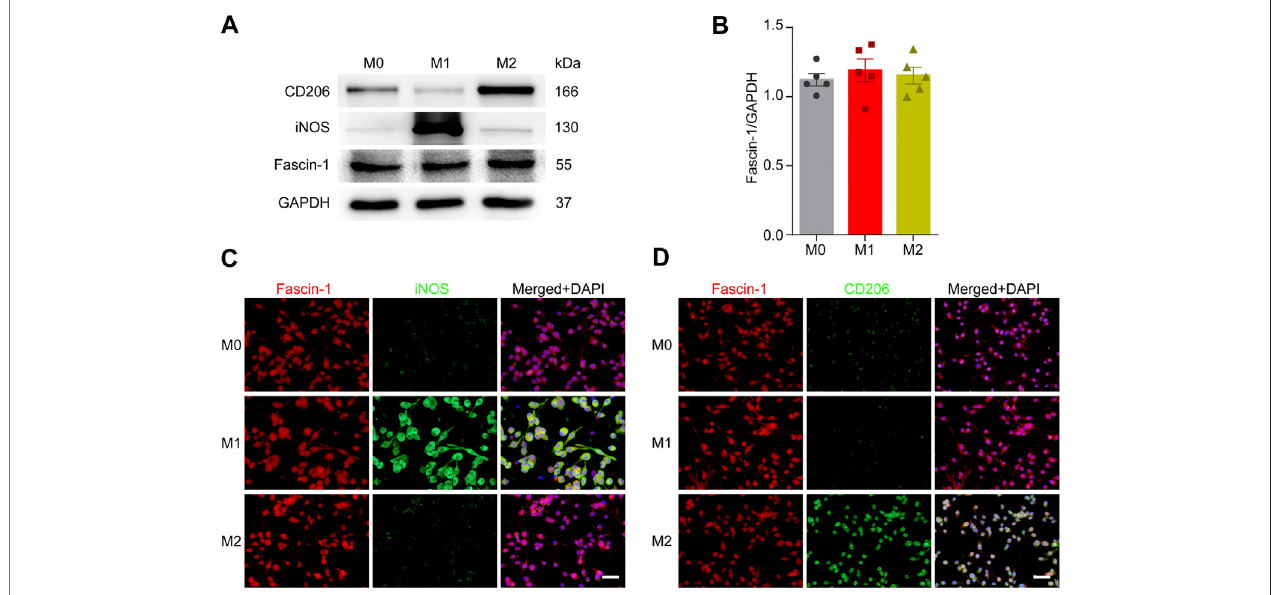
FIGURE 7 | Microglial polarization has no effect on Fascin-1 expression. (A) Western blot analysis shows the protein expression of M1-like (iNOS) or M2-like (CD206) polarization markers and Fascin-1 in BV-2 cells after polarization treatment. (B) Quantitative analysis of Fascin-1 expression in (A) . GAPDH was used as the loading control. The blots ( n (cid:2) 5 per group) were quanti fi ed, as previously described, and no signi fi cant difference was observed. (C,D) Representative immuno fl uorescence imagesof M1-like (iNOS, Green) or M2-like (CD206, Green) markers and Fascin-1(Red) in BV-2 cells after polarization treatment. The results also indicated no obvious differential expression of Fascin-1. DAPI (Blue) was used to stain the nuclei. Scale bar: 50 μ m.